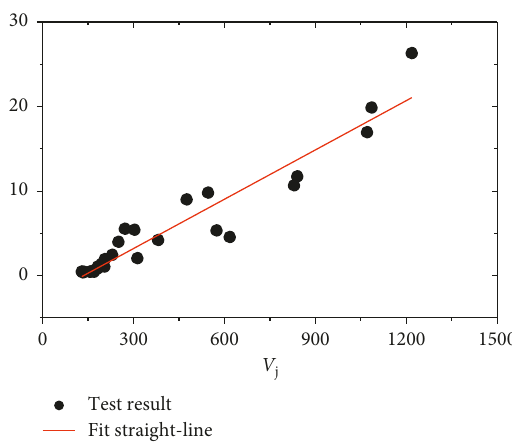
Figure 7: Regression curve of ϕ − V